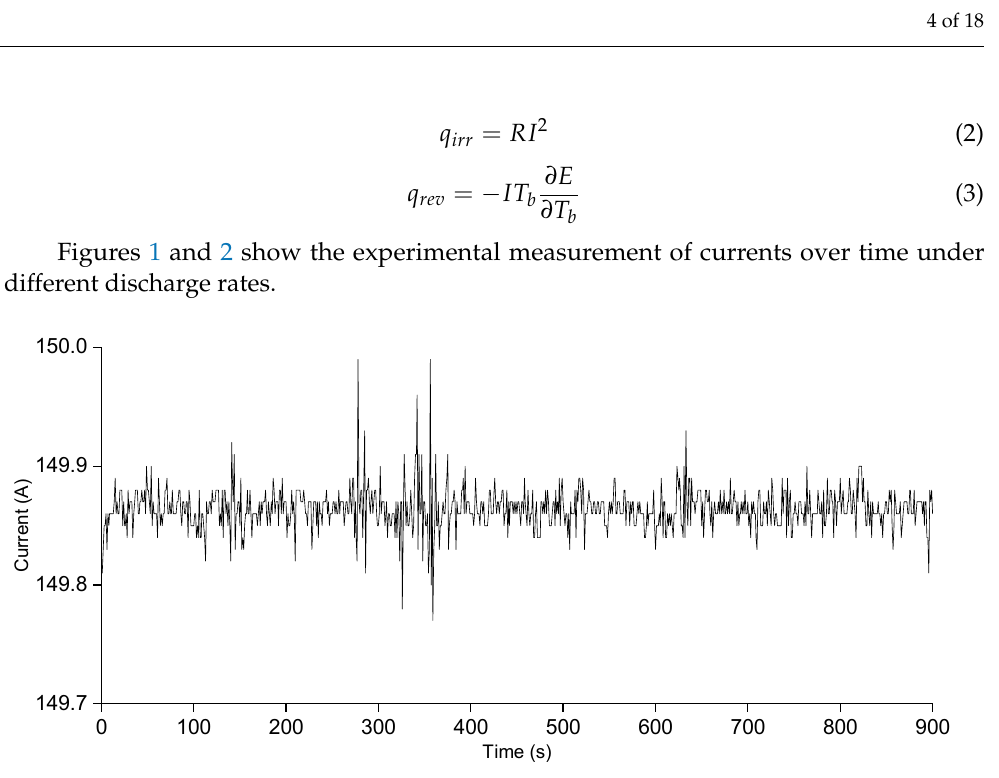
Figure 1. Measured electric current through the battery under 3C discharge rate.